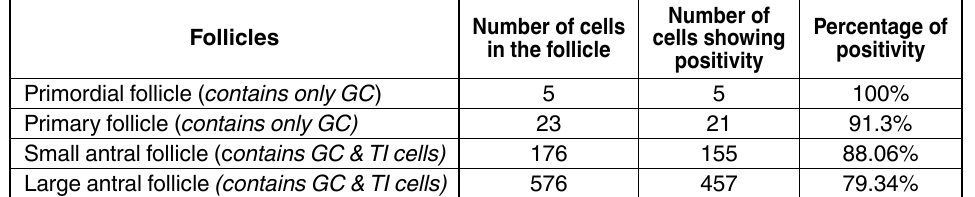
Number of Number of cells Percentage of cells showing in the follicle positivity positivity